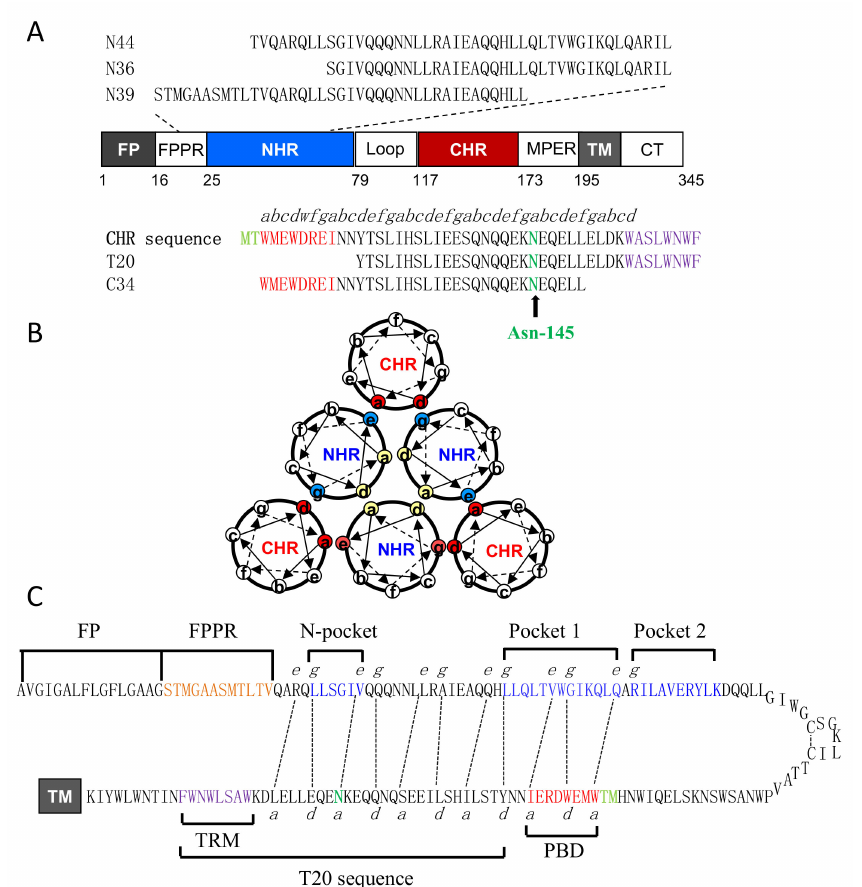
Figure 1. Schematic diagram of HIV-1 gp41 and 6-HB structure. ( A ) Functional domains of HIV-1 gp41 and its NHR- and CHR-derived peptides. The gp41 numbering of HIV-1 HXB2 is used. FP, fusion peptide; FPPR, fusion peptide proximal region; NHR, N-terminal heptad repeat; CHR, C-terminal heptad repeat; TM, transmembrane domain; CT, cytoplasmic tail. The italic “ abcdefg ” on the CHR sequence corresponds to the positions of the amino acids per heptad repeat. The M-T hook residues, pocket-binding domain (PBD), Asn-145 residue, and tryptophan-rich motif (TRM) are respectively marked in aqua, red, green, and purple. ( B ) The helical wheel model illustrating the interactions between the NHR and CHR helices of gp41. The inner NHR homotrimer is packed through the interactions of residues at the “ a ” and “ d ” positions (marked in yellow), whereas its residues at the “ e ” and “ g ” positions (in aquamarine) on the outside of the coiled-coil contact with the residues at the “ a